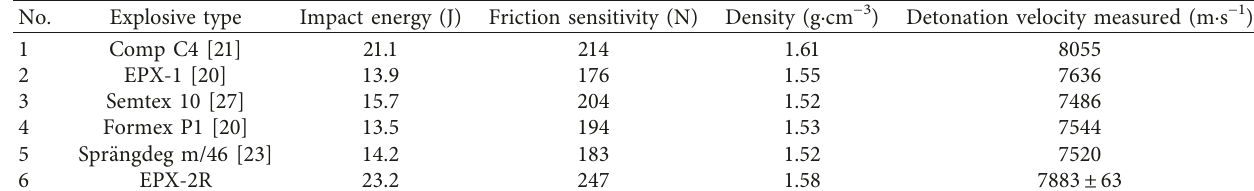
Table 2: The measured characteristics of the studied explosives.